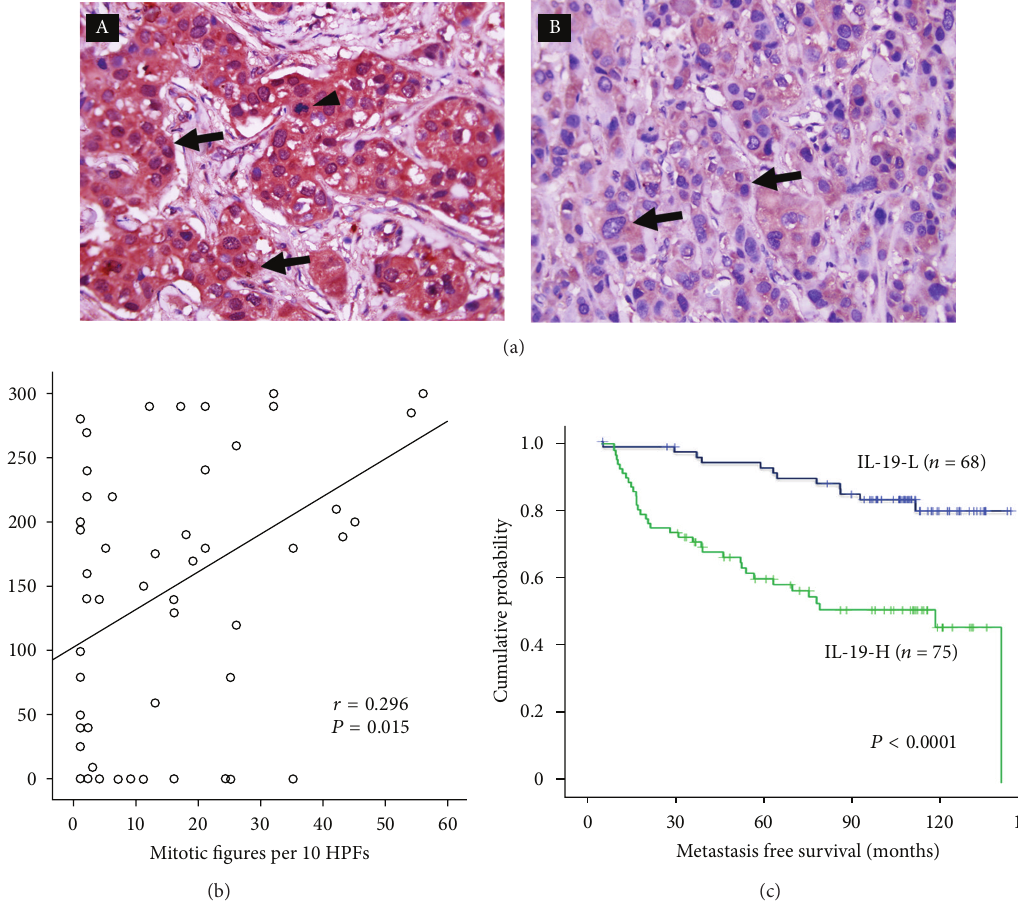
Figure 1: IL-19 expression in breast tumors was correlated with clinical outcome. (a) Immunohistochemical staining (IHC) showed that IL- 19 was strongly (A) or weakly (B) stained in breast invasive duct carcinoma (IDC) cells (arrows) (magnification, × 400). Mitotic figures (A, arrowhead) are commonly found in breast cancer cells strongly stained with IL-19. (b) Mitotic figures were correlated with IL-19 expression levels in breast cancer cells. IL-19 expression levels in 60 IDC tissue samples were analyzed using H scoring. HPFs: high power fields. (c) Of the 143 patients from pathology, Kaplan-Meier plots were used to predict the metastasis-free survival based on IL-19 expression levels. The figure refers to Hsing et al.